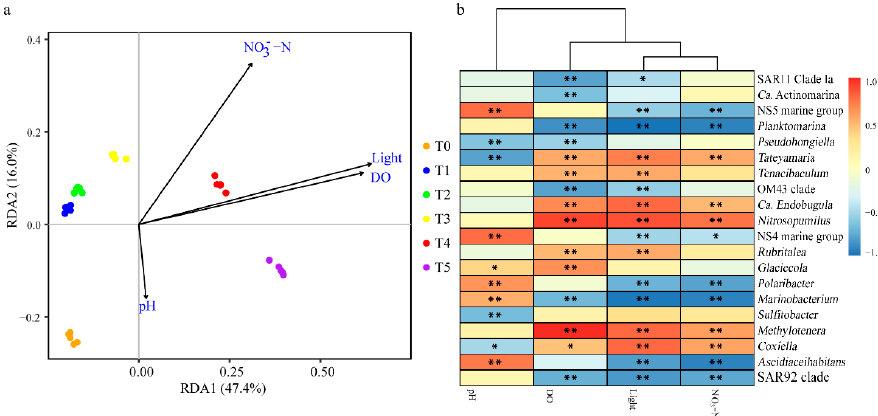
Figure 4. Influences of environmental factors on microbial community variations. ( a ) Biplots of redundancy analysis for microbial communities and environmental parameters. ( b ) Pearson correlation between the most abundant genera and water variables. ** p < 0.01; * p < 0.05.